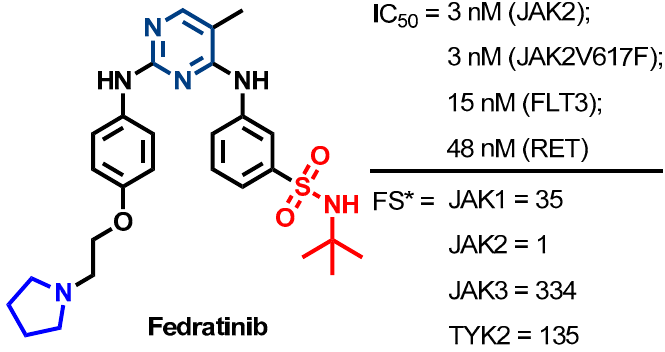
Figure 27. Kinase inhibitory activity of fedratinib (* fold selectivity compared with JAK2).